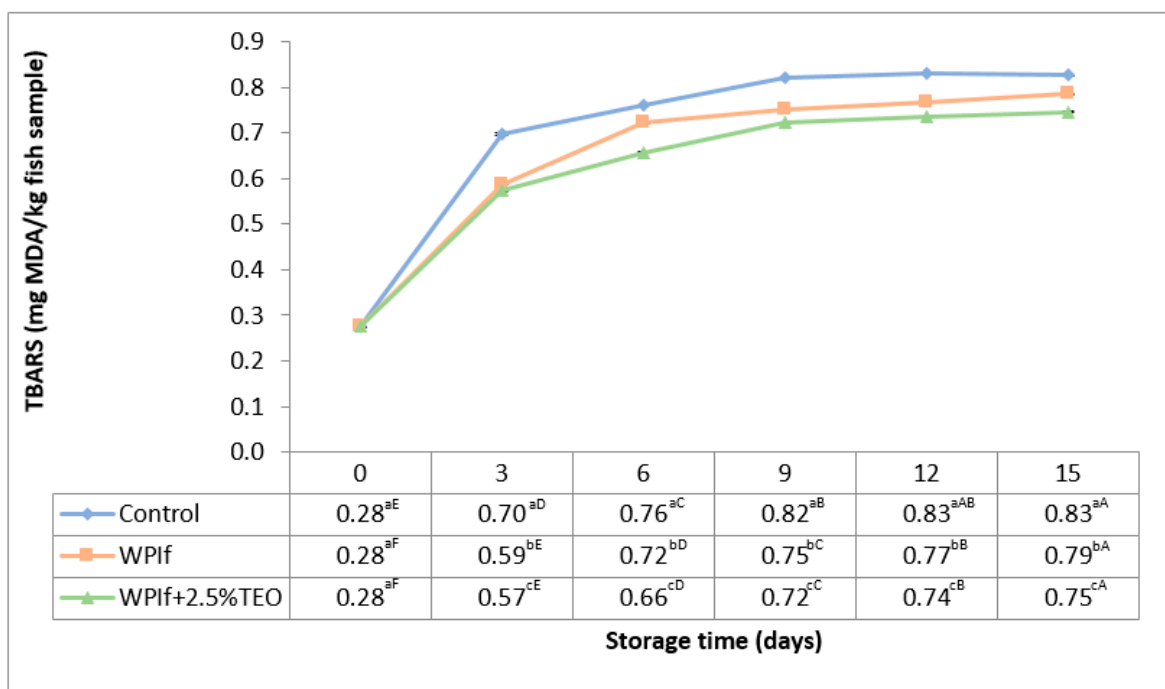
Figure 4. Changes in thiobarbituric acid reactive substances (TBARS) of brook trout samples during refrigerated storage. Control-uncovered fish samples; WPIf-fish samples covered with WPI-based films; WPIf+2.5%TEO-fish samples covered with whey protein isolate-based films incorporated with 2.5% tarragon essential oil. Values are expressed as mean ± standard deviation of three replicates. Means that do not share a letter (lowercase letters on column and uppercase letters on row) are significantly different.